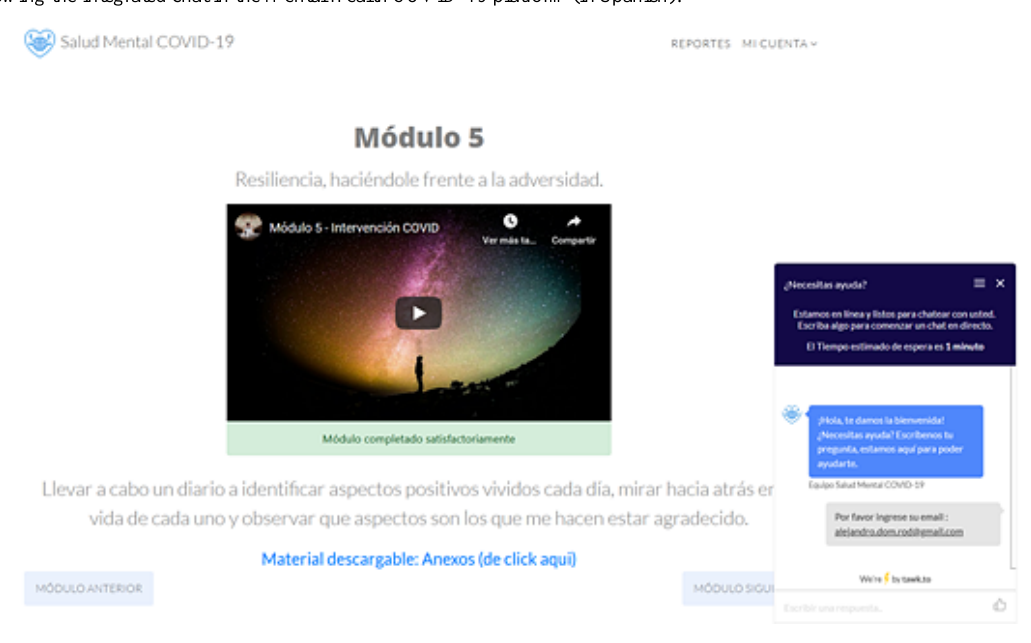
Figure 4. Screenshot showing the integrated chat in the Mental Health COVID-19 platform (in Spanish).